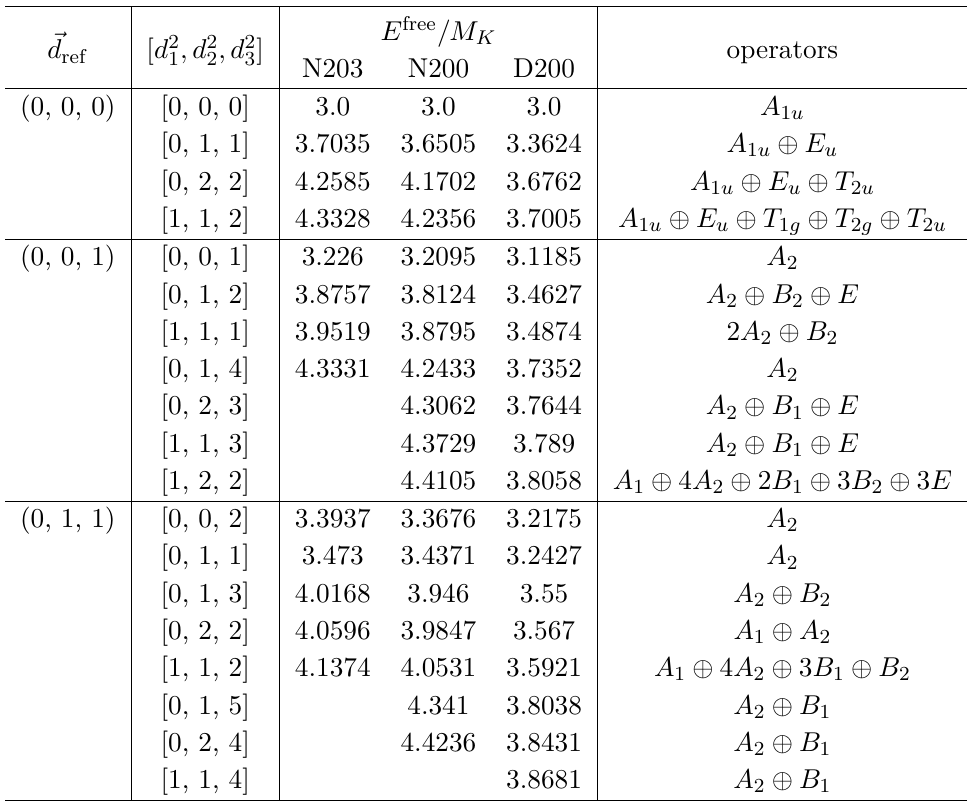
Table 24. Same as table 21 except for the three-kaons operators with ~d 2